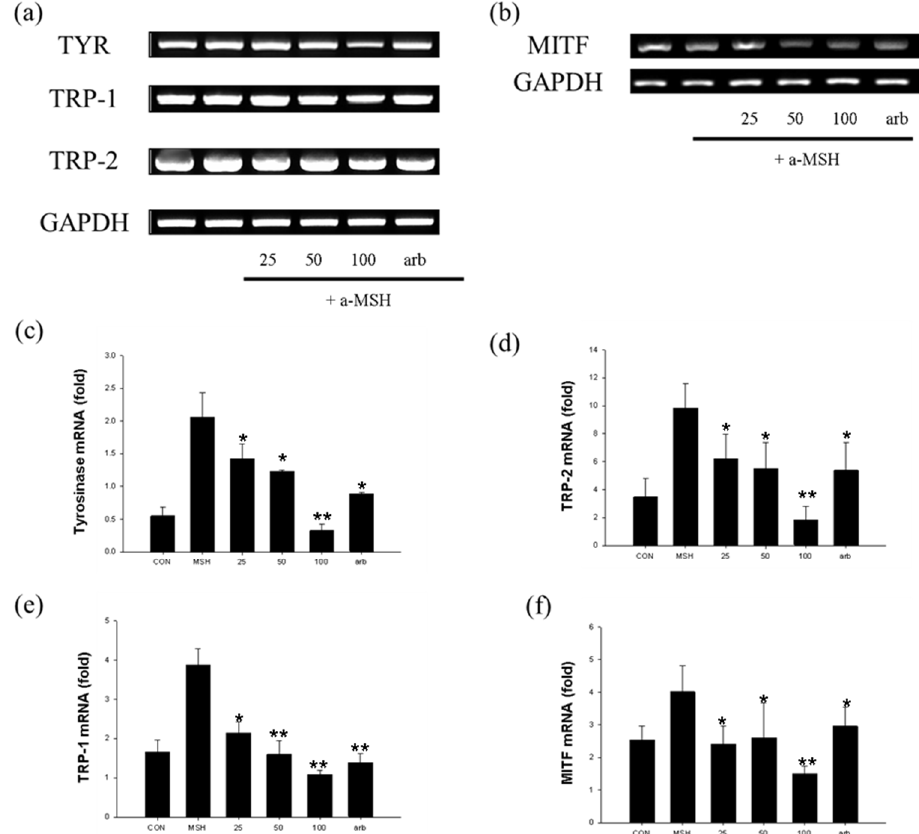
Figure 9. RT-PCR analysis of nomilin. ( a ) TYR, TRP-1, and TRP-2 transcripts were analyzed using RT-PCR. The level of GAPDH mRNA was used as control. ( b ) MITF transcripts were analyzed using RT-PCR. The level of GAPDH mRNA was used as control. ( c ) Effects of nomilin on tyrosinase, ( d ) TRP-1, ( e ) TRP-2, and ( f ) MITF mRNA in B16F10 cells. Data from separate experiments are presented (statistically significant compared with the vehicle-treated control, * p < 0.05, ** p < 0.01, bars indicate SD). α -MSH: α -melanocyte-stimulating hormone, MITF: microphthalmia-associated transcription factor, TYR: tyrosinase.